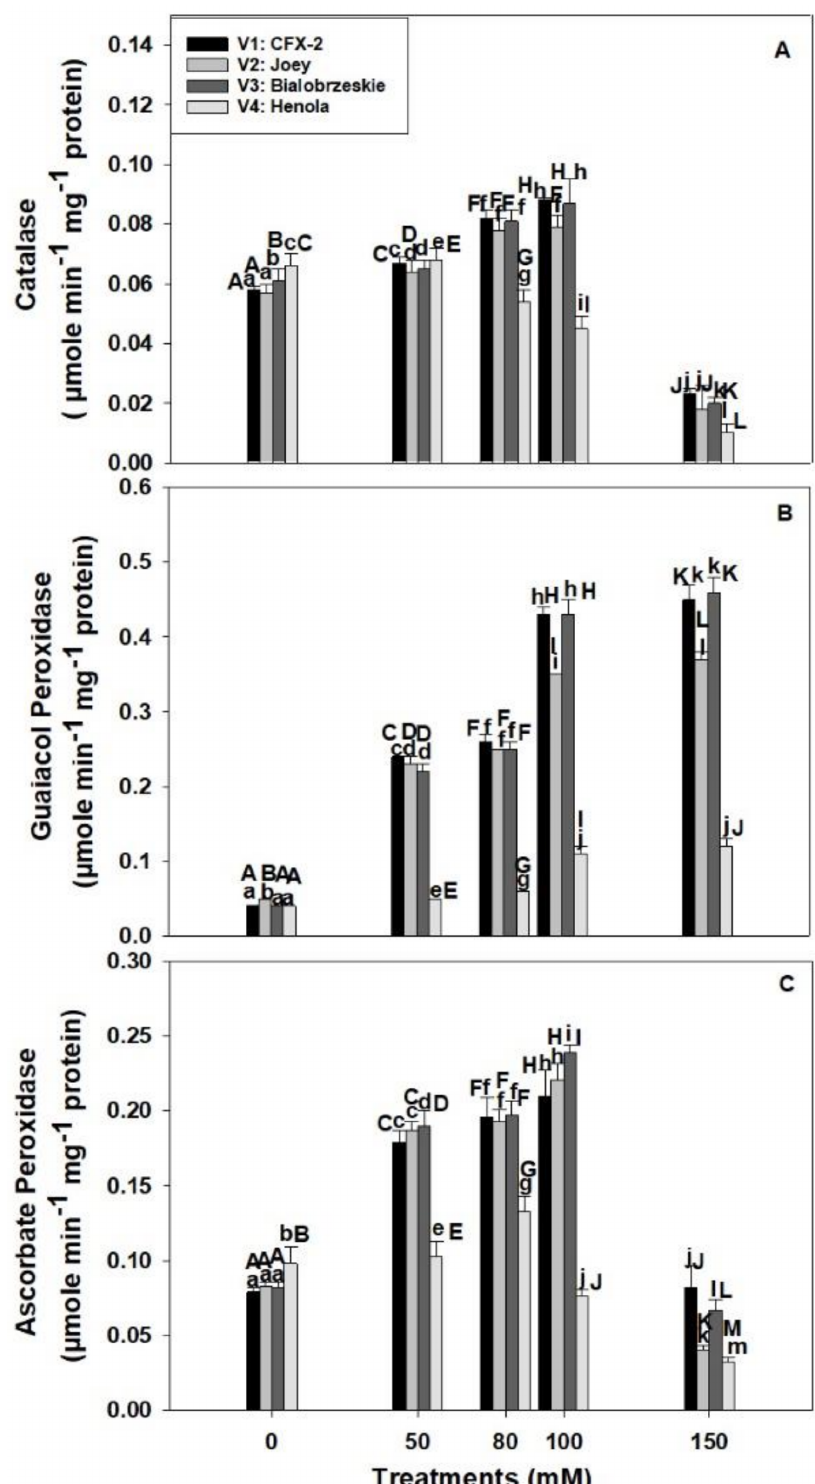
Figure 3. Effects of NaCl on IH root CAT specific activity ( A ), GPOD specific activity ( B ), and APOD specific activity ( C ). Vertical bars represent SE. Different capital letters indicate significant differences among the varieties and lower case letters represent significant treatment differences. These mean values ( n = 15) are separated using LSD at p <